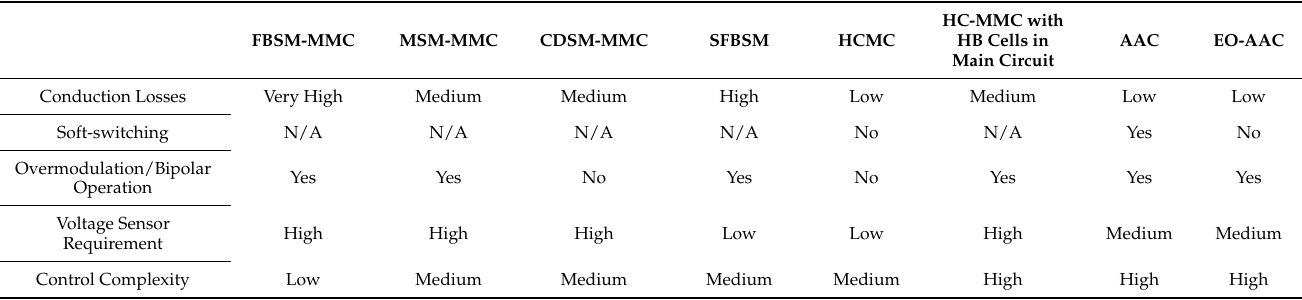
Table 5. Comparison among MMC